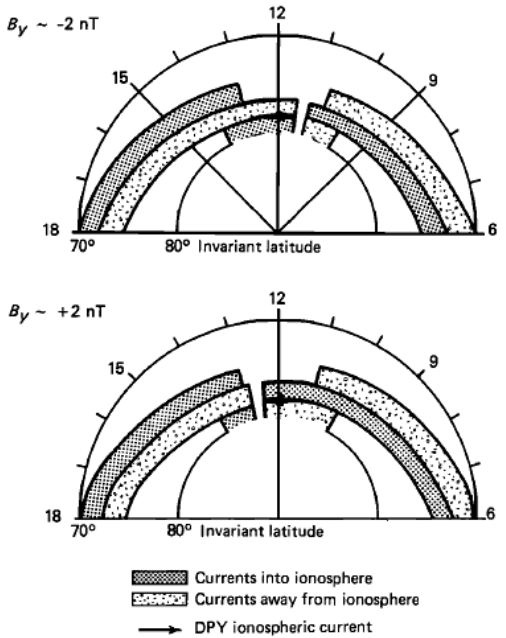
Figure 8. Sketch of the dayside Birkeland currents, modified from the statistical pattern developed by Iijima and Potemra (1976b), in the Northern Hemisphere for IMF B y near − 2nT and + 2nT (Fig. 11 from Erlandson et al.,